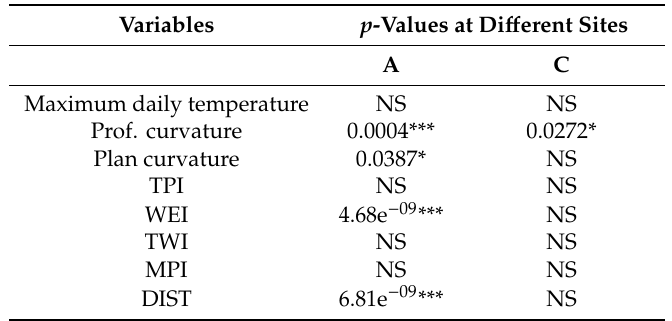
Table 7. Tested variables and their significance on juvenile